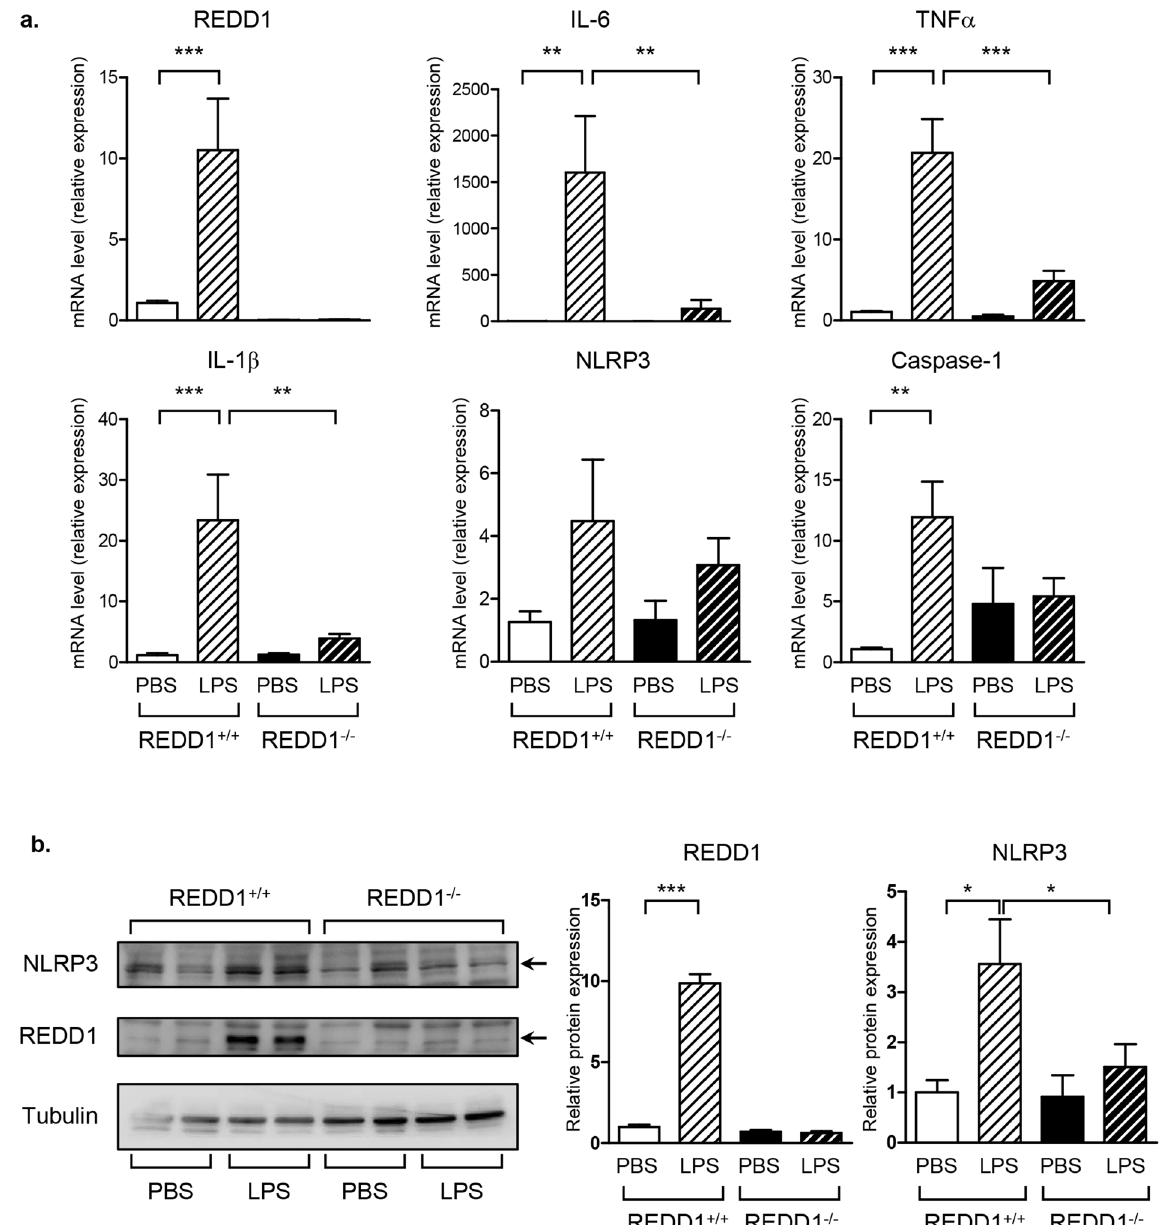
Figure 1. Inflammation was decreased in adipose tissue of REDD1 − / − mice injected with LPS. REDD1 + / + and REDD1 − / − mice were injected intraperitoneally with LPS (2 µ g/g of body weight). After 5 hours, epididymal adipose tissue were recovered and ( a ) mRNA expression was determined by quantitative RT-PCR (n = 3 independent experiments with a total of 13 mice/group) and ( b ) protein expression was determined by immunoblots. Quantification of relative expression of NLRP3 and REDD1 is shown. (n = 4 mice/group) * p < 0.05; ** p < 0.01, *** p <